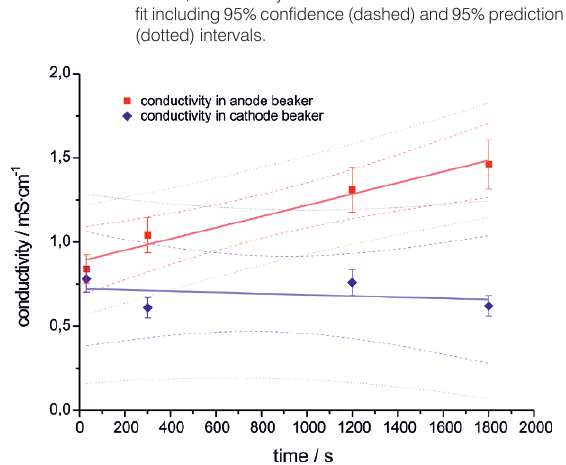
Figure 6. Exp. 1b: Transport of phenol from anodic to cathodic beaker, conductivity measurement evaluated with a linear fit including 95% confidence (dashed) and 95% prediction (dotted) intervals.